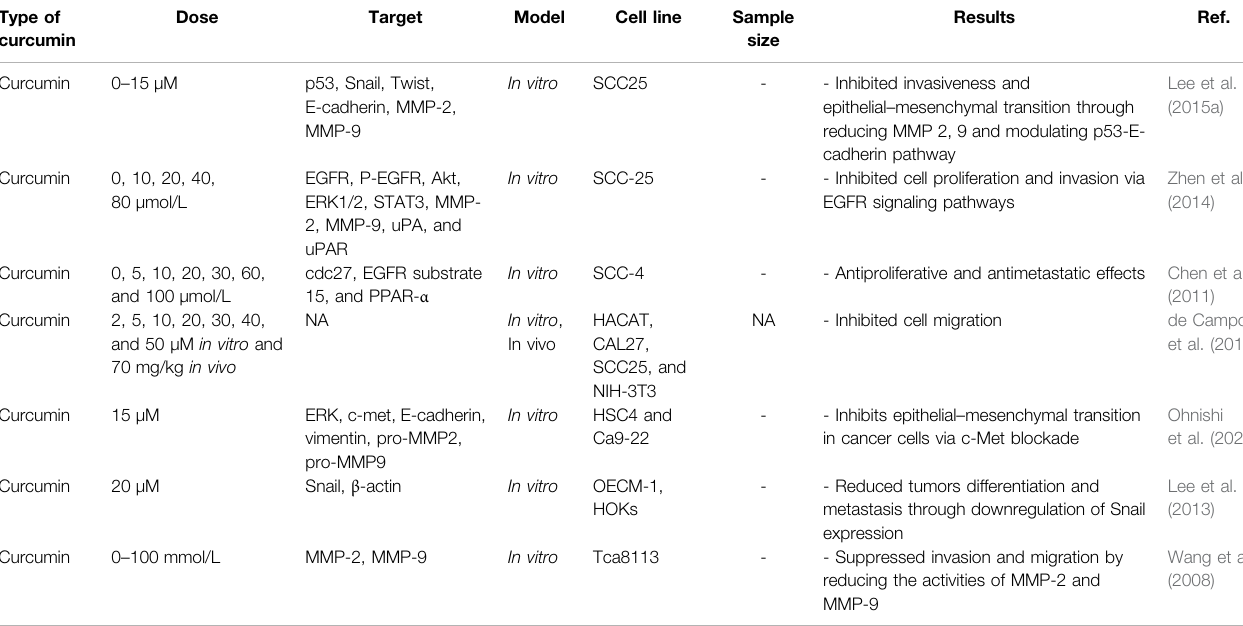
TABLE 4 | Ef fi cacy of curcumin for triggering metastasis in oral cancer. Type of